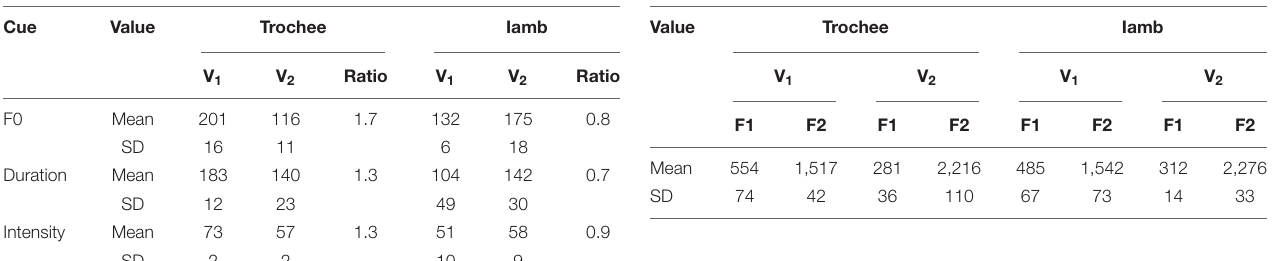
TABLE 1 | Mean values of nonce words. TABLE 2 | Nonce word vowel